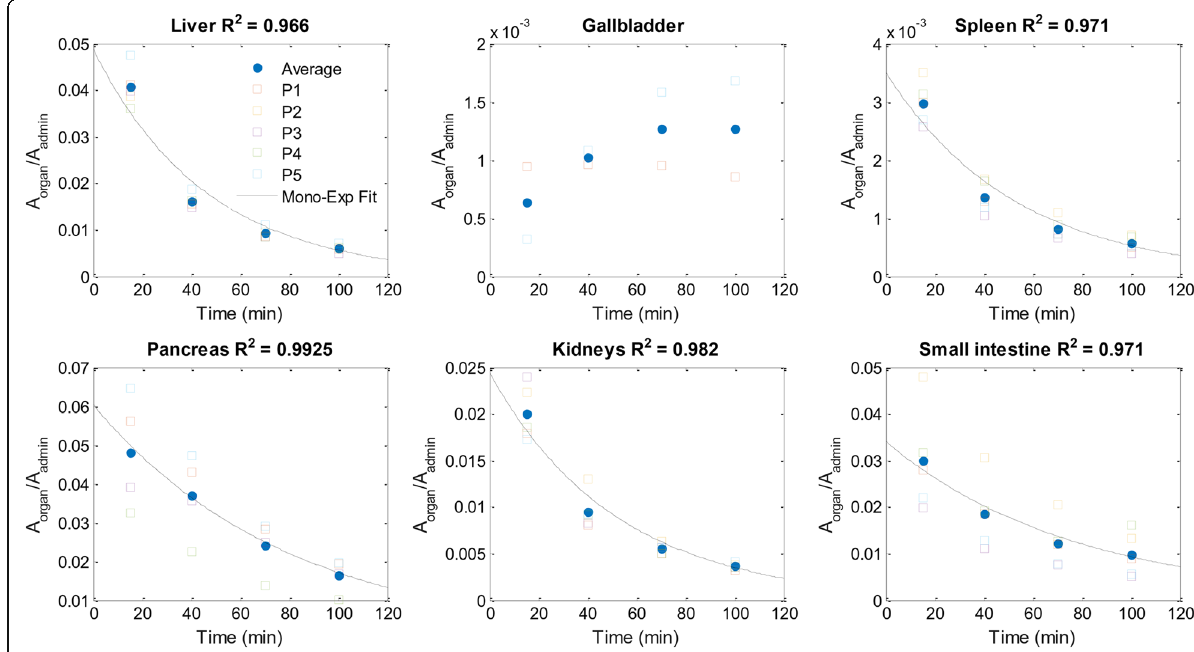
Fig. 2 68 Ga-NODAGA-MJ9 normalised time-activity curves for most relevant abdominal organs. The organ activity was normalised to the patient administered activity. Coloured squares indicate patient-related data points. Blue dots indicate the normalised activity (mean±SD) obtained at each time point. The coefficient of determination ( R 2 ) of the mono-exponential fit (except for the gallbladder, see methods) is reported for each organ. Due to previous surgery, gallbladder and pancreatic normalised time-activity curves were available for two and four patients only,